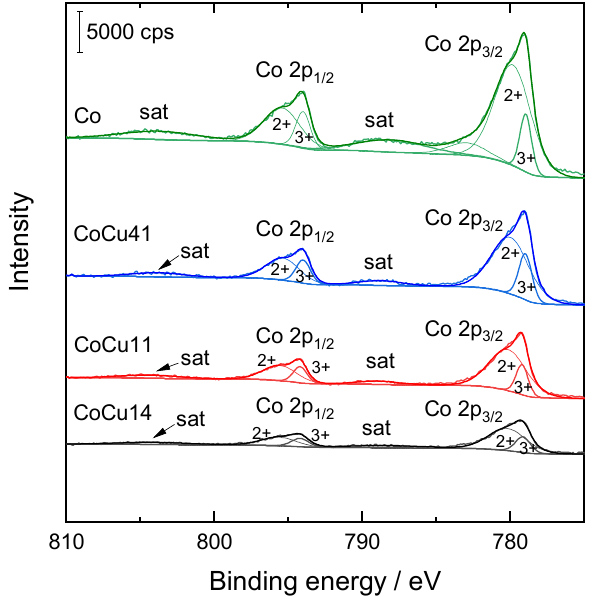
Figure 5. The Co 2p XPS spectra of the Co-Cu oxide catalysts. Table 5. Surface concentrations of the elements in at. % determined by XPS analysis of the exam- ined Co-Cu oxide catalysts.